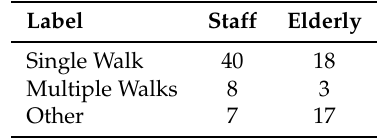
Table 2. Quantity and nature of the signals contained in our dataset. Data were split into training and test using stratified random sampling along the classes single walk, multiple walks and other. Label Staff Elderly Single Walk